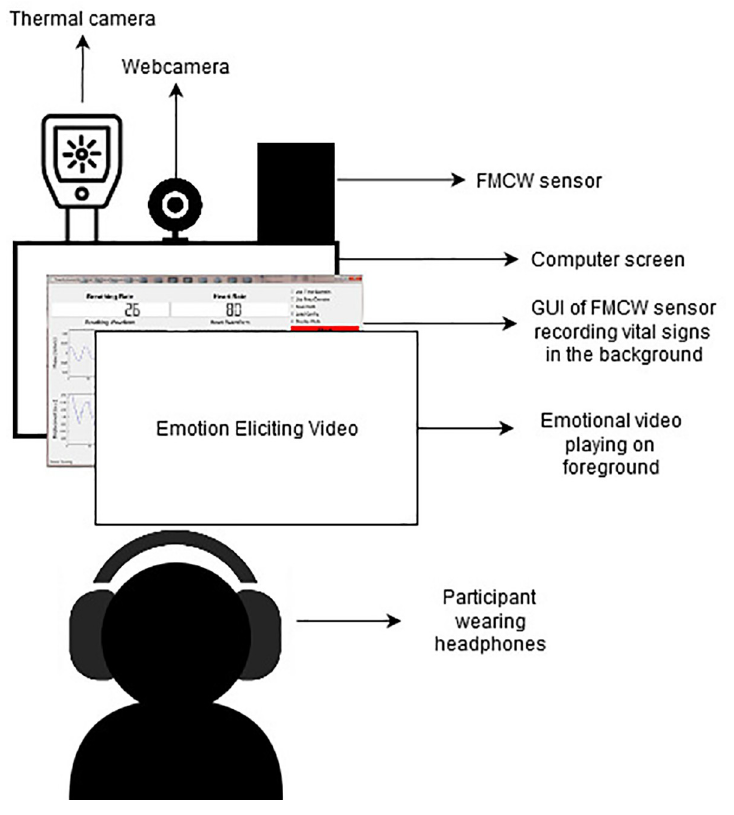
Fig 1. Experiment